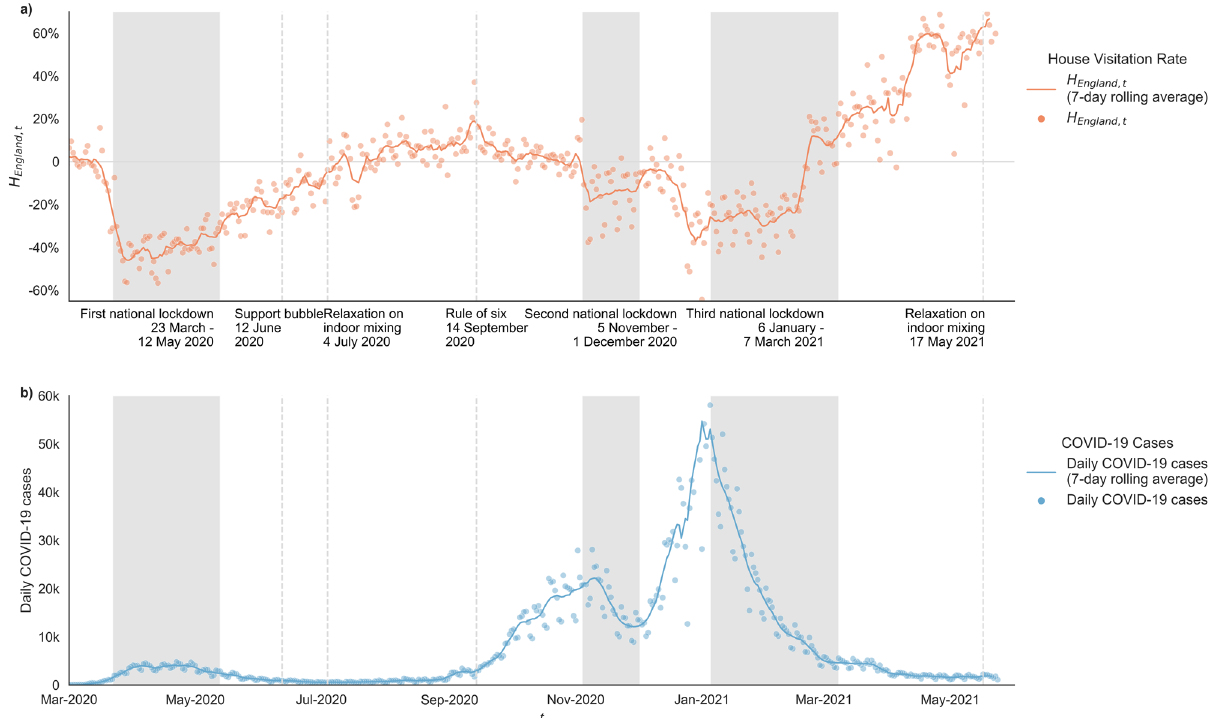
Figure 1. Changes of ( a ) H England , t and ( b ) daily new COVID-19 cases in England between March 1st 2020 to May 24th 2021. For each day, the national H England , t is aggregated from the H l , t of each local authority. Accounting for the day of week effect, H England , t is also illustrated with the rolling 7-day average. New COVID- 19 cases are the number of cases by specimen date. Time periods or time points where indoor mixing rules were changed were marked